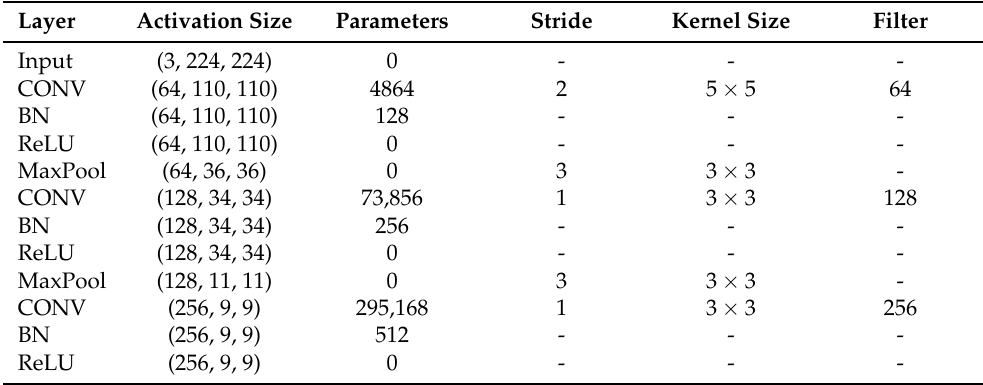
Table 2. Detail configuration of the proposed